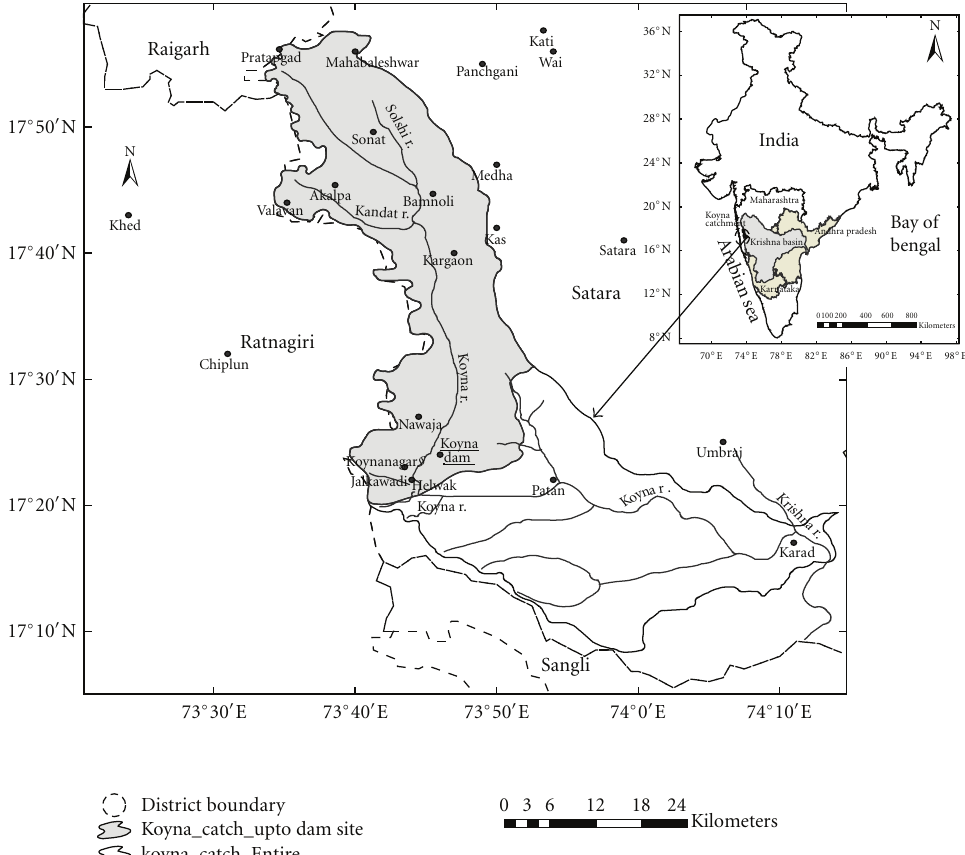
Figure 1: Illustrated map of the Koyna catchment in the Peninsular